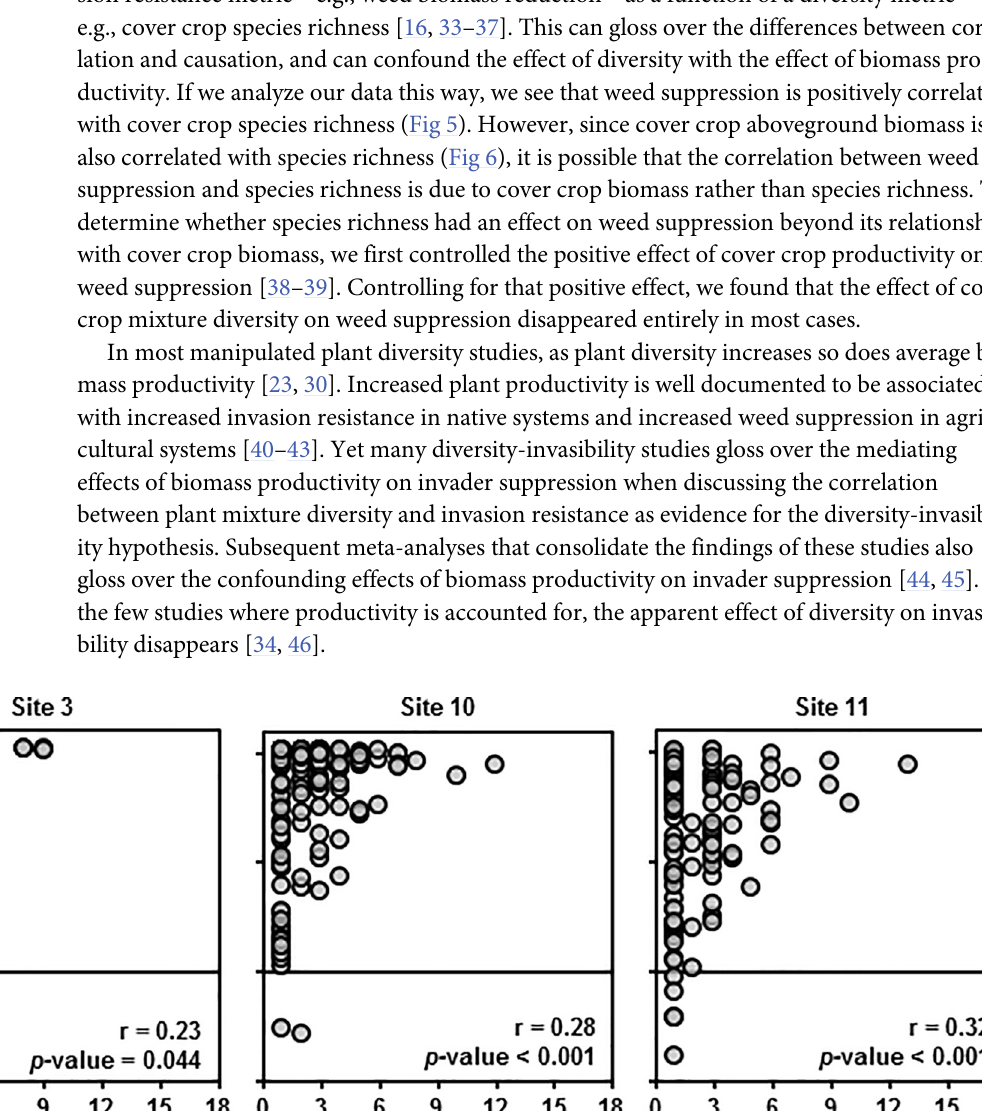
PLOS ONE | https://doi.org/10.1371/journal.pone.0206195 March 14,